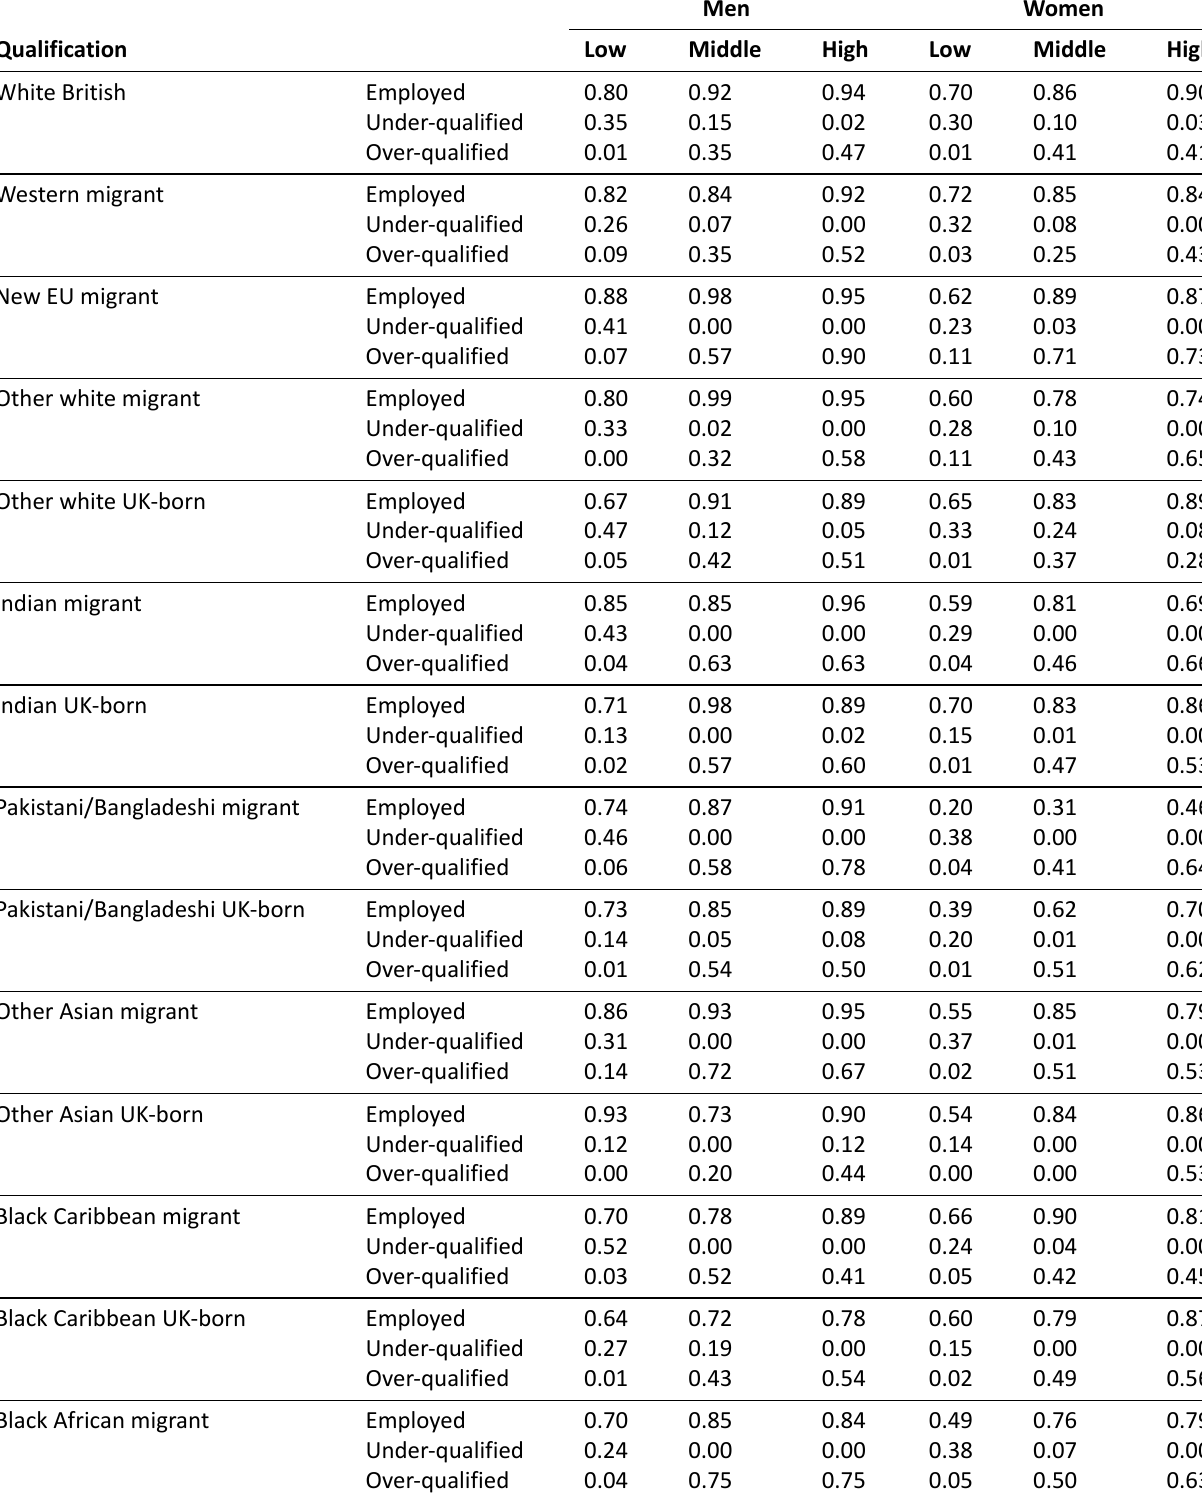
Table A2. Probability of employment and match with qualifications by qualifications and gender. Source: Understand- ing Society 2009-2017, showing labour market outcomes by qualifications (low: at most upper secondary, middle: post- secondary non-tertiary, or high: tertiary) (Knies,